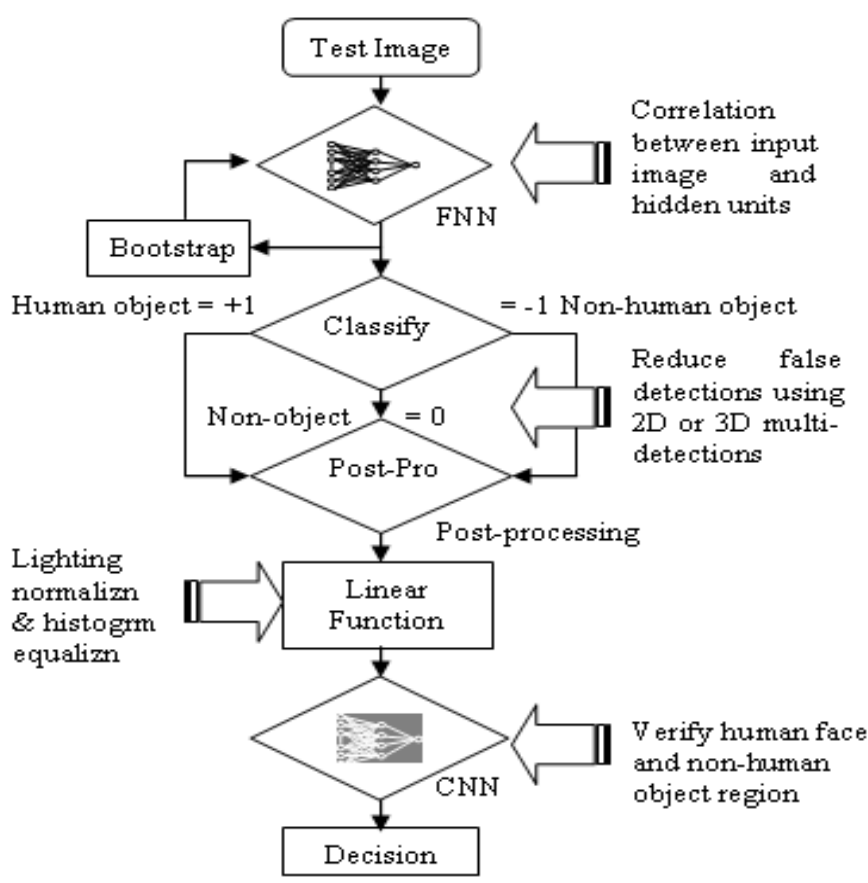
Figure 1. Neural network algorithm for occupancy